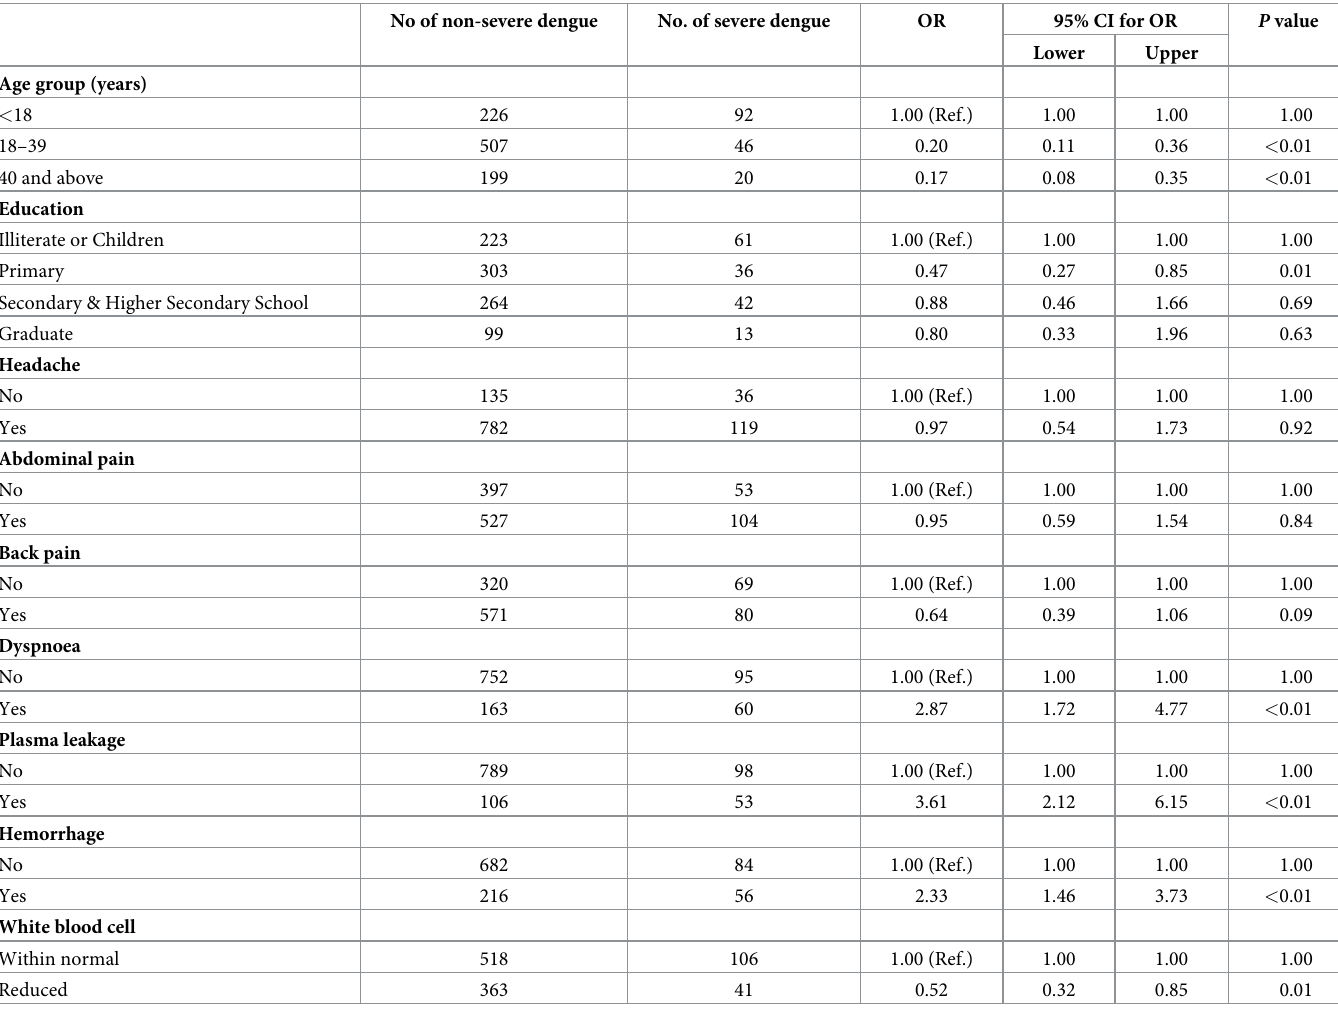
1.46 to 3.73), plasma leakage (OR = 3.61, 95% CI: 2.12 to 6.15), and dyspnoea (OR = 2.87, 95% CI: 1.72 to 4.77) were positively associated with the risk of severe dengue (Table 2). The hemor- rhage mainly occurred in the gum, hematochezia, and menorrhagia, and plasma leakage mainly in abdomen and chest (S5 Table). Furthermore, severe dengue in the non-DSS group was significantly higher in participants with plasma leakage or hemorrhage than in those with- out plasma leakage or hemorrhage (S6 Table). Compared to illiterate, primary education was associated with a lower risk of severe dengue (OR = 0.47, 95% CI: 0.27 to 0.85). Compared to patients aged < 18 years, patients aged 18–39 years (OR = 0.20, 95% CI: 0.11 to 0.36) and > 40 years (OR = 0.17, 95% CI: 0.08 to 0.35) had less likely to have severe dengue (Table 2). CART models Model I: Demographic characteristics. The CART analysis showed that age (threshold: 11.5 years old) was the main associated factor, explaining 43.1% of severe dengue. S3 Fig shows that the prevalence of severe dengue was 55.2% for women aged between 1.9 and 11.5